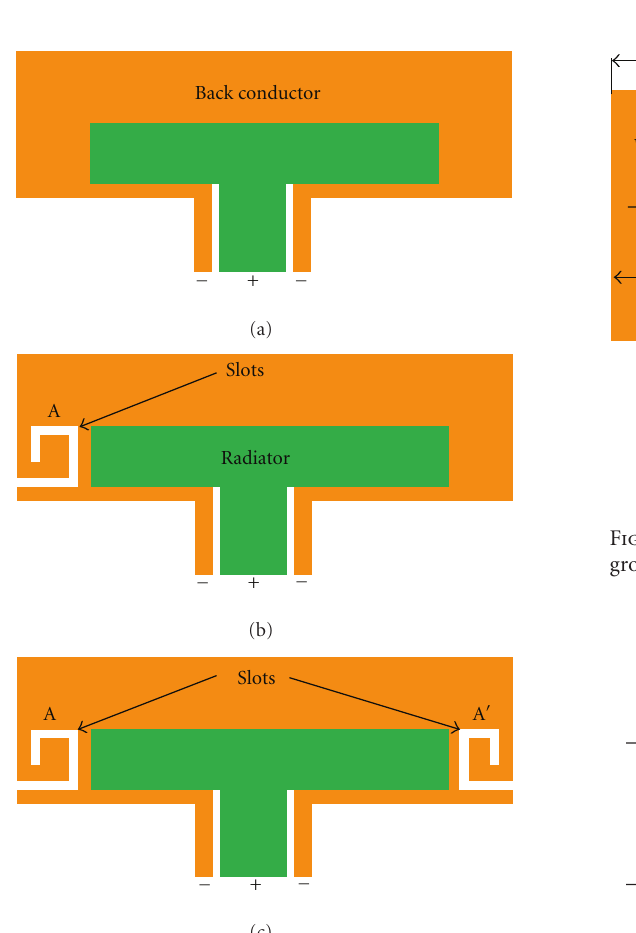
Figure 1: Geometry of the proposed antenna with (a) no slot, (b) slot (A), and (c) slot (A (cid:2) ).